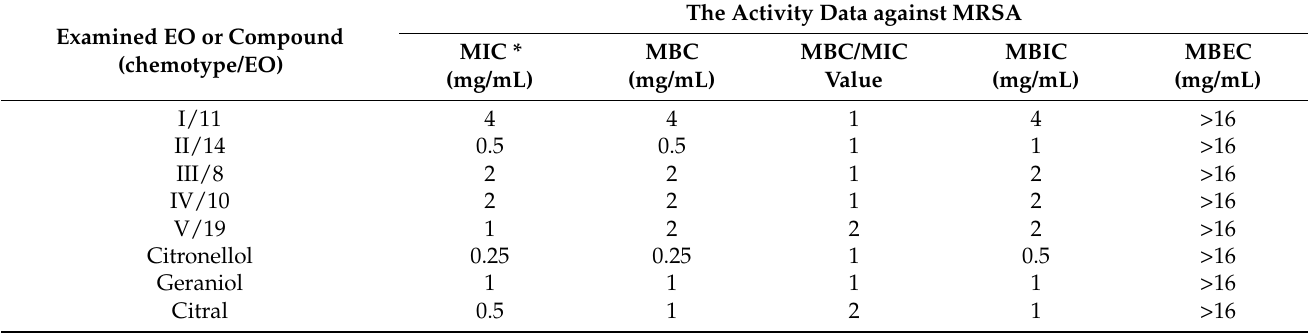
Table 2. Activity data of the examined EOs or their main compounds against the reference strain of Methicillin-resistant Staphylococcus aureus ATCC 43300. For EO numbering, see Table 4. Examined EO or Compound